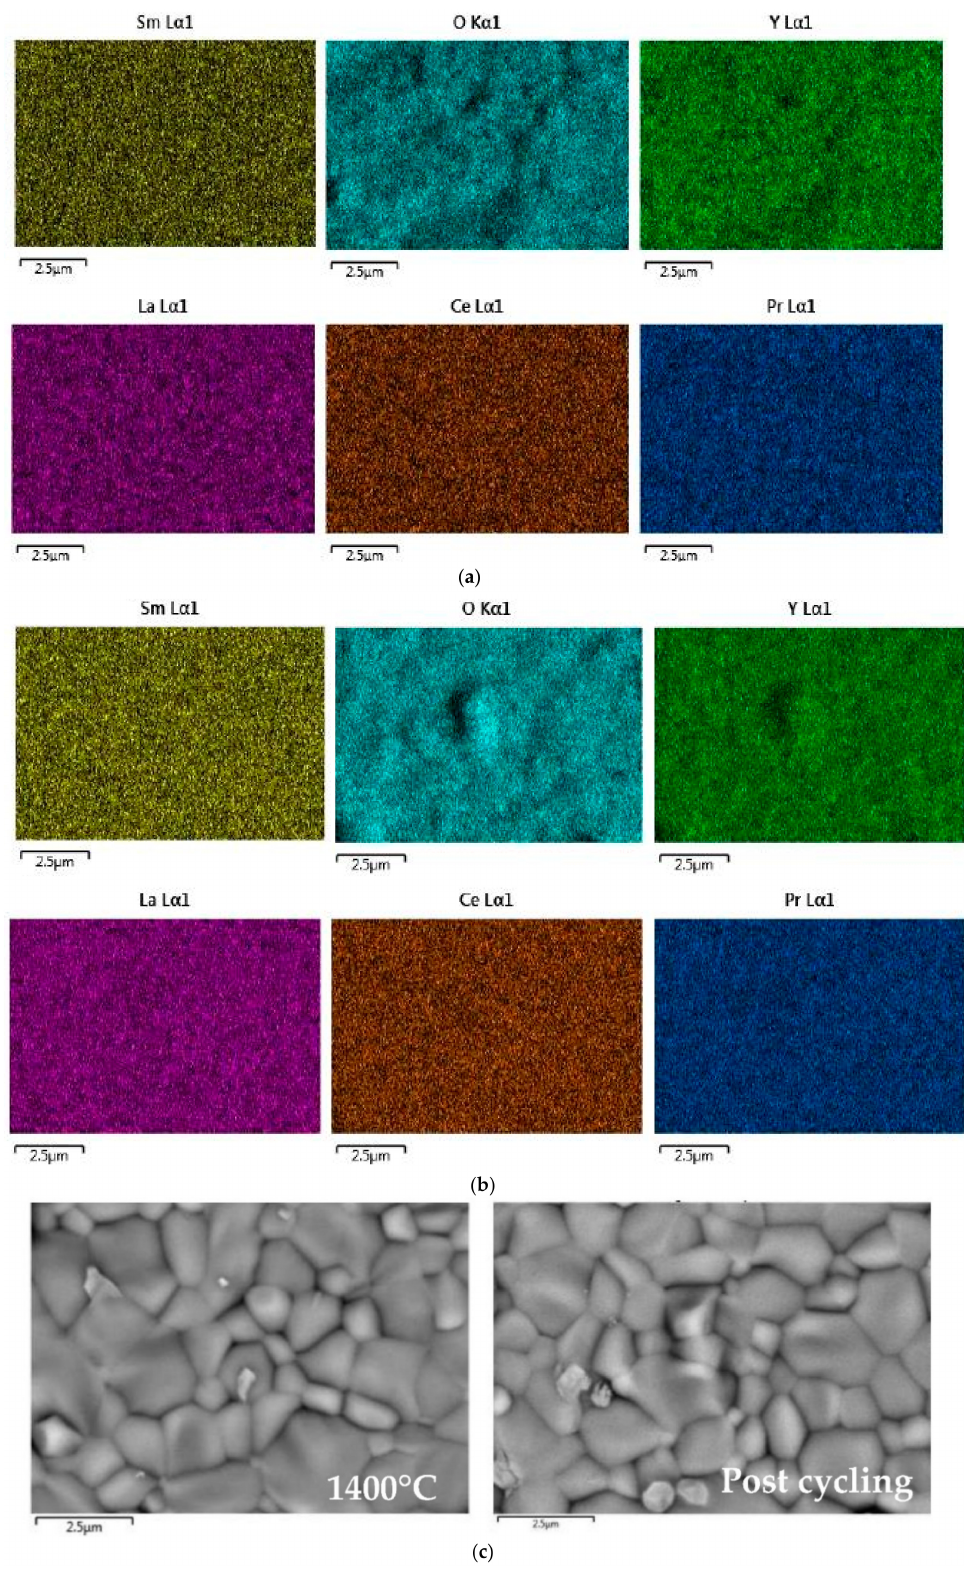
Figure 6. EDS analysis of HEO 3: ( a ) elementary cartography after annealing at 1400 ◦ C; and ( b ) after cycling. ( c ) SEM analysis of HEO 3 before and after